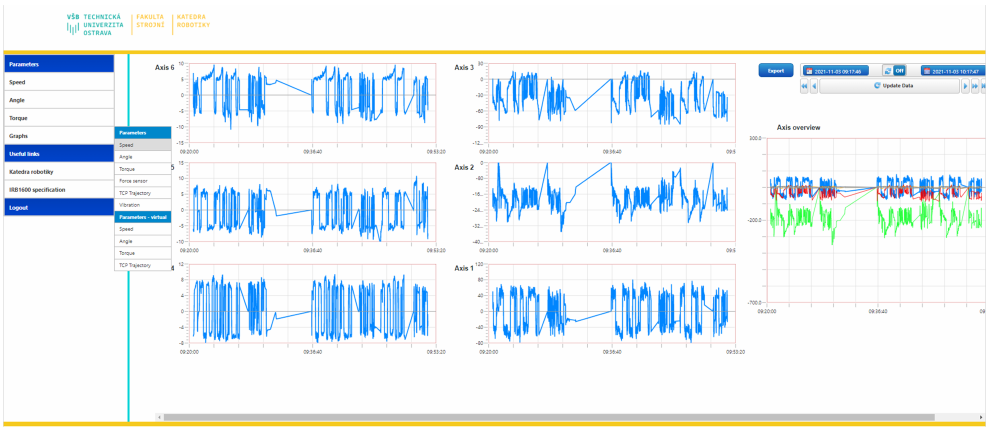
Figure 11. The figure shows that data can be displayed in a web browser. This is used to quickly view the measurement progress or to check the robot parameters. A great advantage is the ability to preview this from